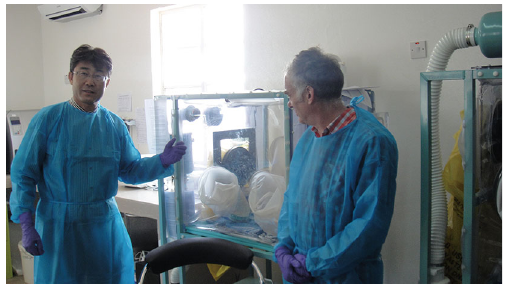
Figure 2. The Deputy Director-General of the China CDC, Dr. George F. Gao, worked in Sierra Leone as the co-team leader of the fi rst team of the mobile laboratory from September to November, 2014.